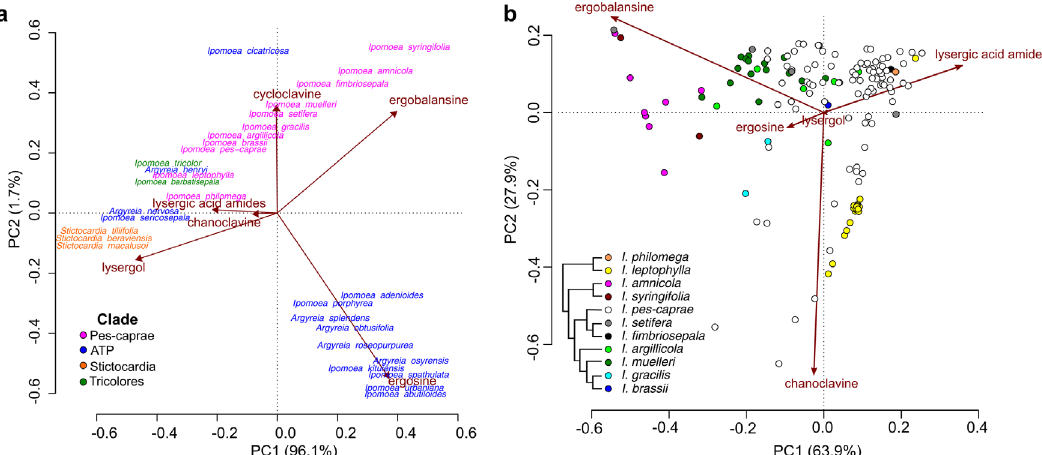
Fig. 4 Clustering of alkaloid pro fi les in EA + species. a Phylogenetic PCA of EA + species colored by the four major clades. EA values are averaged for each species. b PCA of EA + species in the Pes-caprae